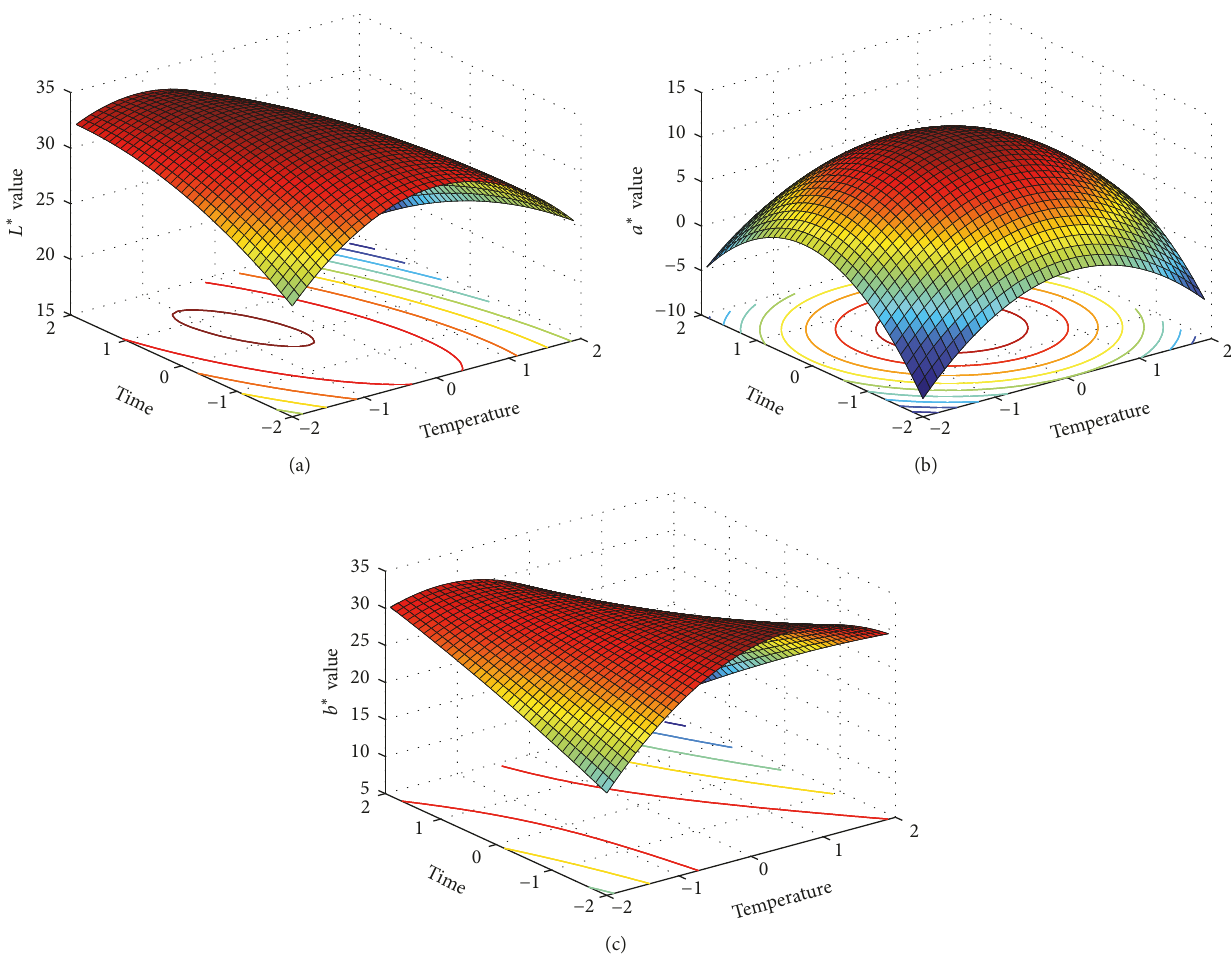
Figure 2: The surface plots of color instrumental. 𝐿 ∗ value (a), 𝑎 ∗ value (b), and 𝑏 ∗ value (c) as affected by roasting time and temperature.